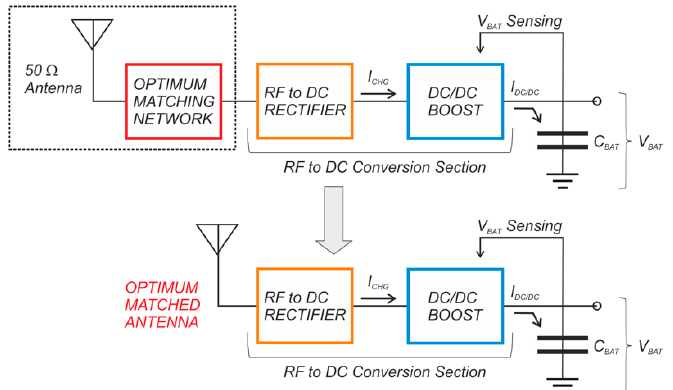
Figure 2. Architecture of the proposed harvesting system (below) compared with the canonical architecture (above).